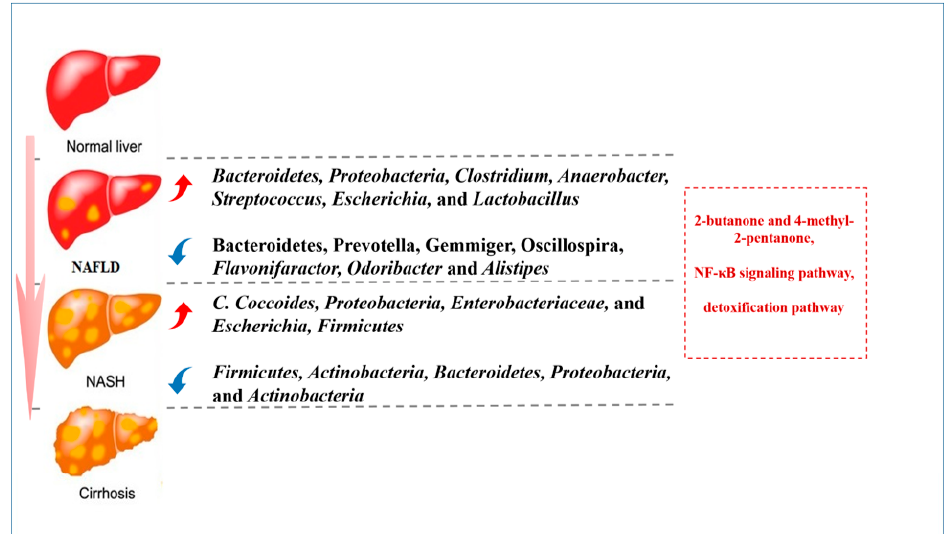
Figure 3. The potential signaling pathways and alteration of gut microbiota in patients with NAFLD/NASH. The figure shows the alteration of gut microbiota and potential signaling pathways in the process from normal liver to NAFLD/NASH, and finally to